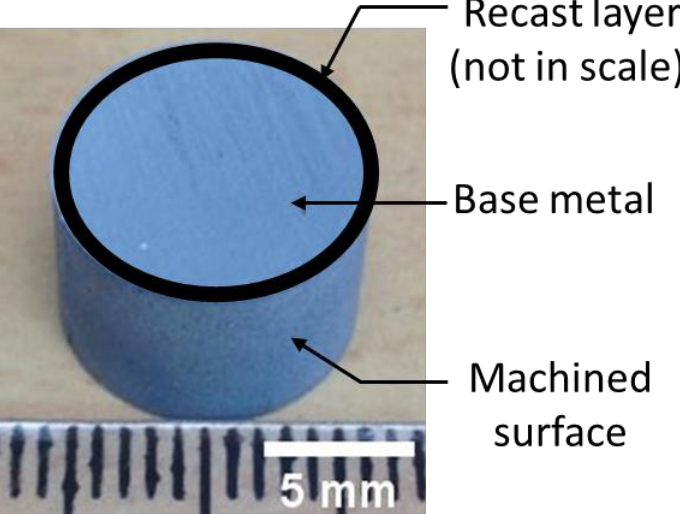
Figure 1. Optical photo of the cylindrical block cut by WEDM from the workpiece with the location of the recast layer (overlay) and machined surface.